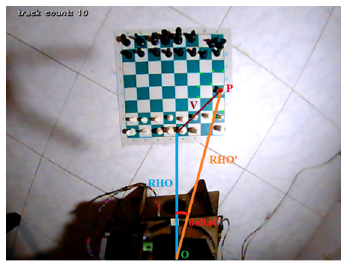
Figure 12. Position unknown for the guide point.